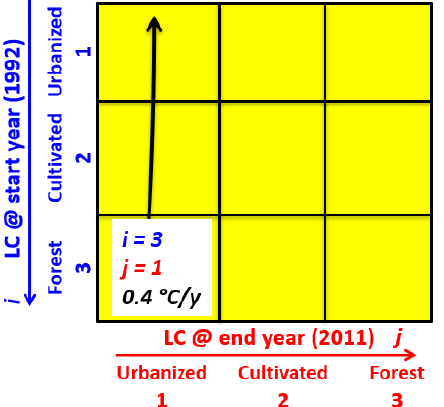
Figure 5. Representation of the LC changes within the Rate Matrix : the row index ( i ) represents the initial LC class and the column index ( j ) the final LC class. As an example, the highlighted cell represents the transition from the Forest class ( i = 3) to the Urbanized class ( j = 1), with an estimated LST increasing rate of 0.4 ◦